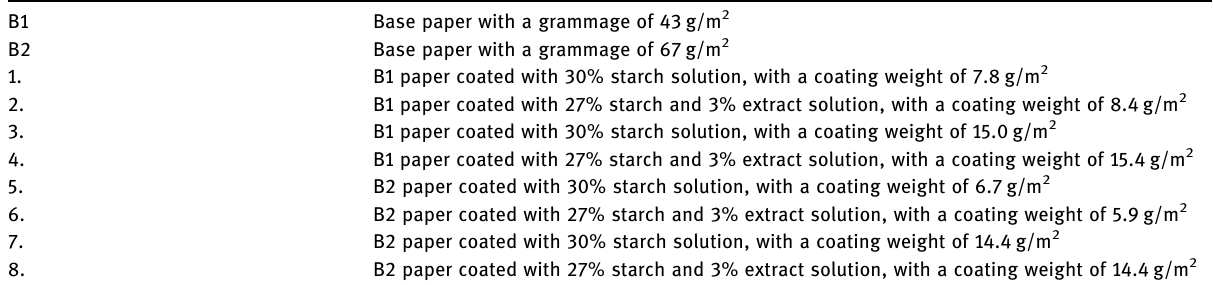
Table 1: Description of the tested papers